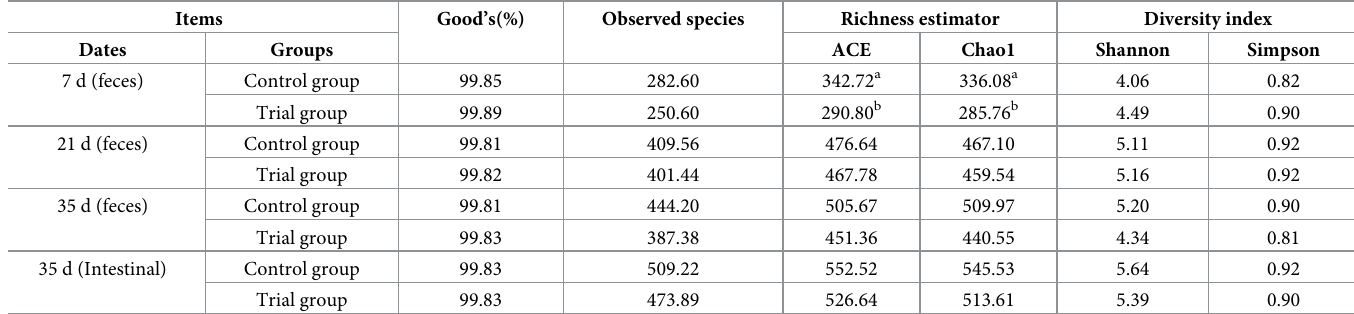
Table 4. Alpha diversity of bacterial flora in rat feces.